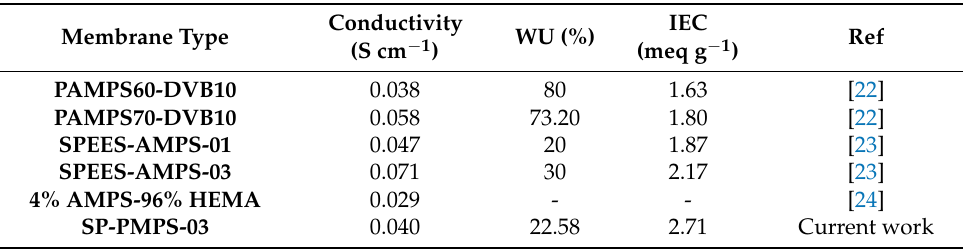
Table 2. Comparison table for conductivity with the reported literature based on poly (2-acrylamido- 2-methylpropanesulfonic acid).